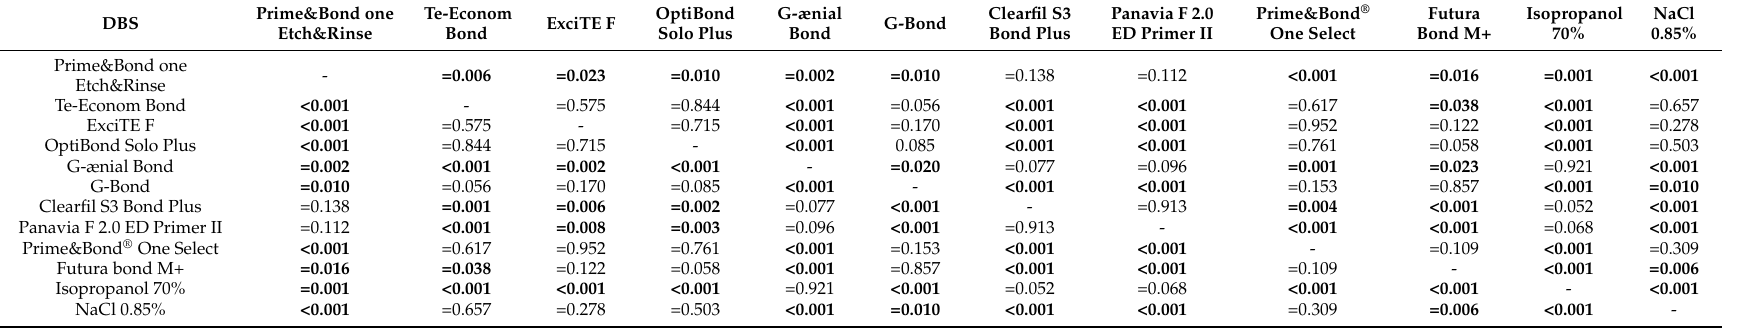
Table 2. Levels of statistical significance for post hoc pairwise comparisons of percentages of dead cells, based on Fisher’s protected least-significant difference